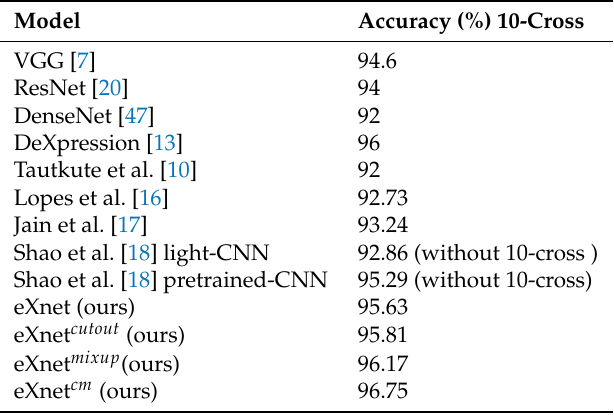
Table 5. Comparison of eXnet with benchmark networks on the CK+